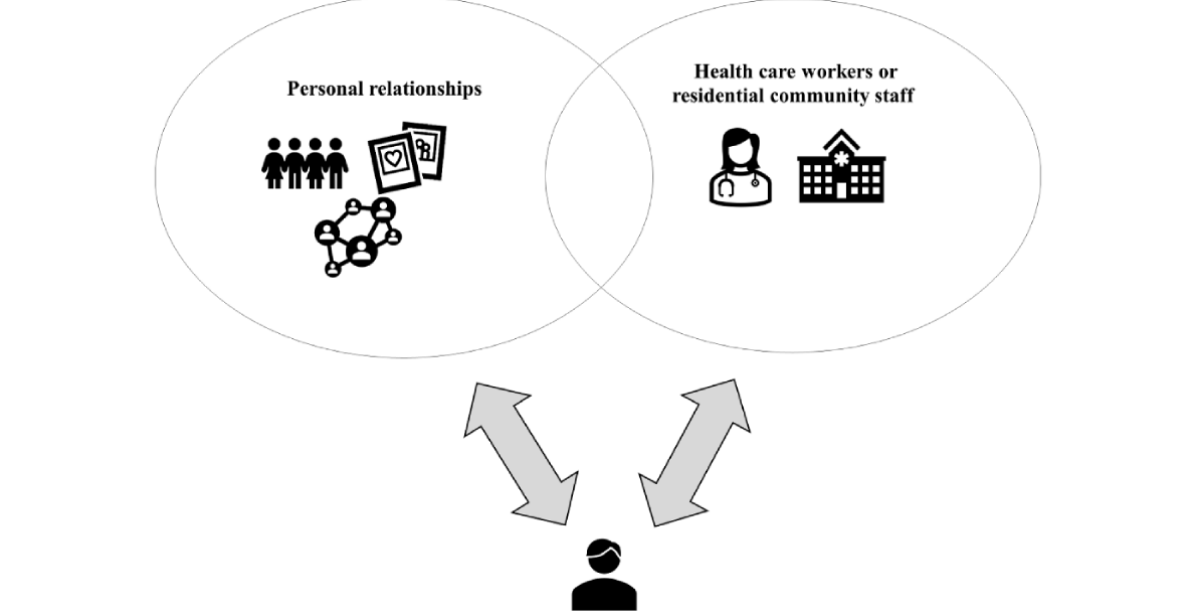
Figure 4. Socio-organizational environment of older adult's personal health information management: stakeholders